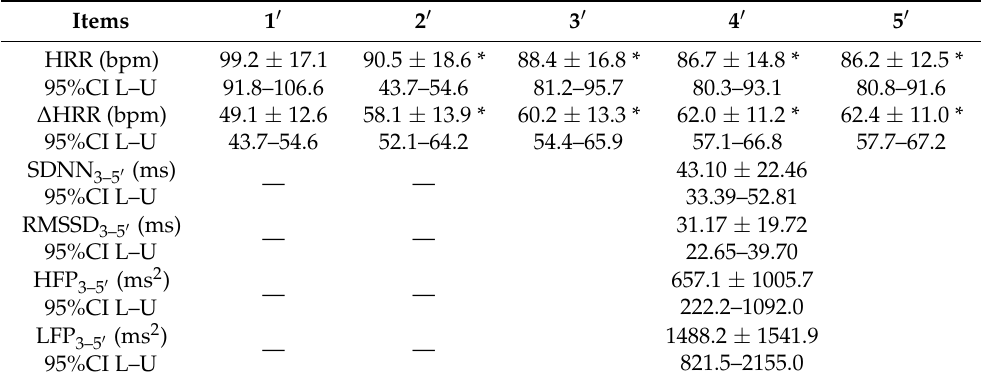
Table 4. Recovery heart rate and recovery heart rate variability among study participants.